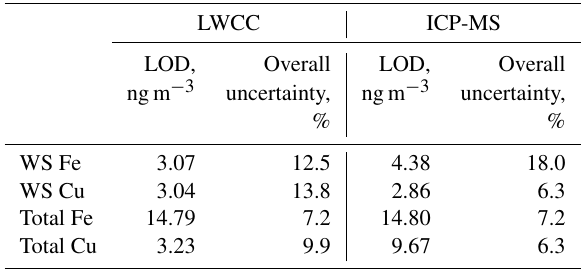
Table 1. Limits of detection, blanks and uncertainties for WS Fe, WS Cu and total Cu for the liquid spectrophotometric (LWCC) and ICP-MS